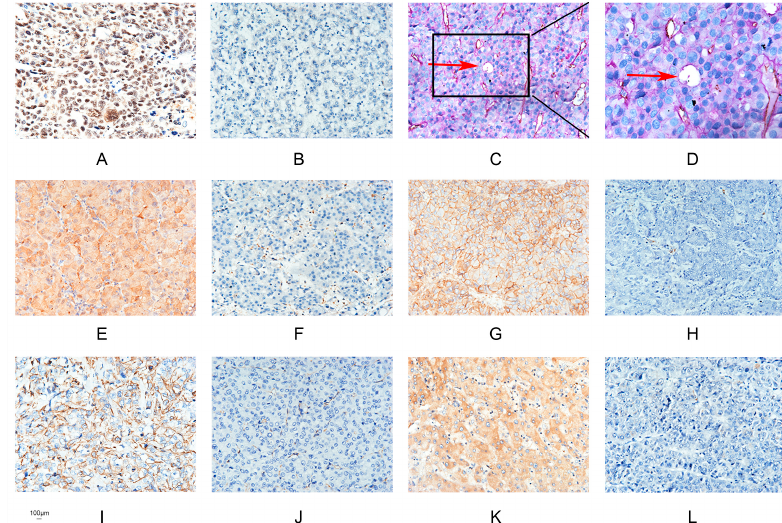
Figure 1. Hepatocellular carcinoma specimens were analyzed by immunohistochemistry. ( A ) Runx2 was predominantly localized in the nuclear of cancer cells ( × 200; bars 100 µ m); ( B ) Negative expression of Runx2 ( × 200; bars 100 µ m); ( C ) CD31/PAS double staining displayed VM channels (Red arrow) in Hepatocellular carcinoma specimens ( × 200; bars 100 µ m); ( D ) VM channels (Red arrow)( × 400; bars 100 µ m); ( E ) Nuclear and cytoplasmic staining of Galectin-3 ( × 200; bars 100 µ m); ( F ) Negative expression of Galectin-3 ( × 200; bars 100 µ m); ( G ) Positive E-cadherin expression ( × 200; bars 100 µ m); ( H ) Negative E-cadherin expression ( × 200; bars 100 µ m); ( I ) Positive Vimentin expression ( × 200; bars 100 µ m); ( J ) Negative Vimentin expression ( × 200; bars 100 µ m); ( K ) Positive VE-cadherin expression ( × 200; bars 100 µ m); ( L ) Negative VE-cadherin expression ( × 200; bars 100 µ m).